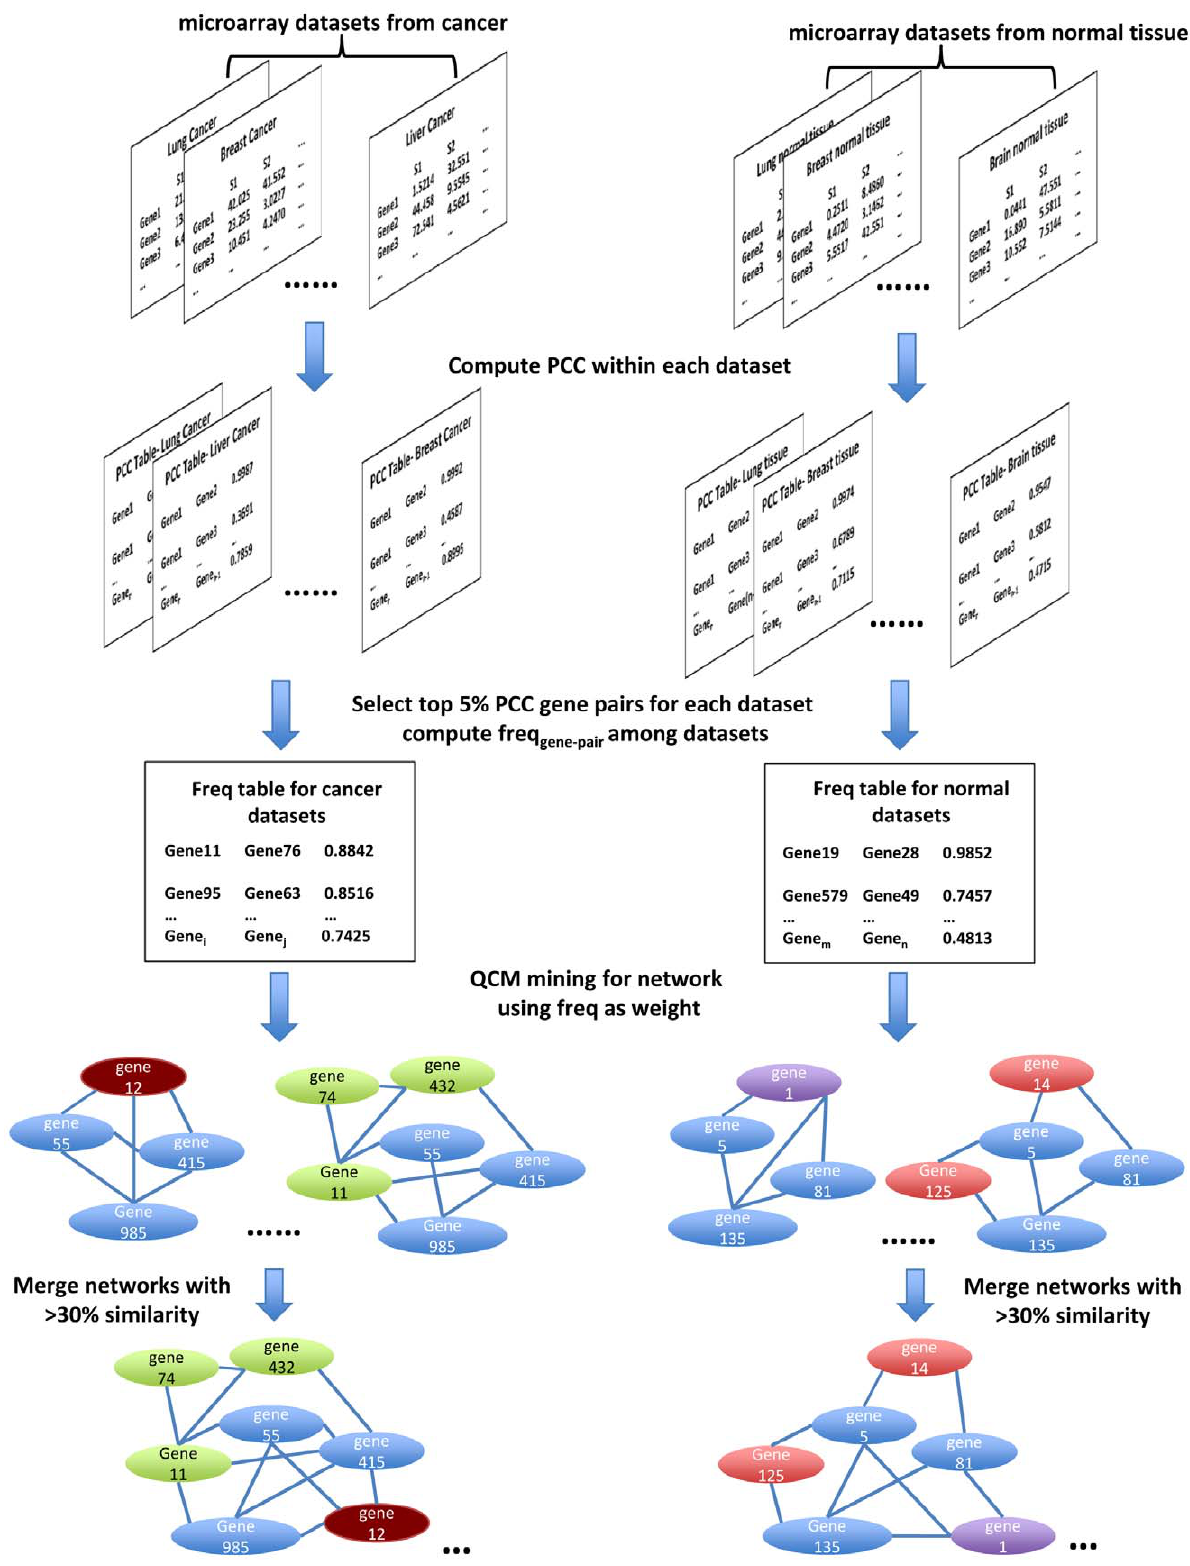
Figure 1. Workflow to mine frequent co-expression network using QCM from cancer and normal tissue microarray datasets. Blue ovals indicate gene members shared by different networks, ovals in other colors indicate genes unique to each network.